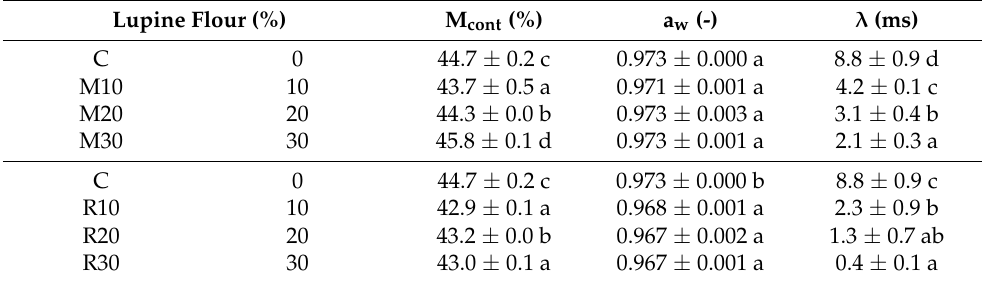
Table 1. Hydration parameters of lupine wheat flour dough.